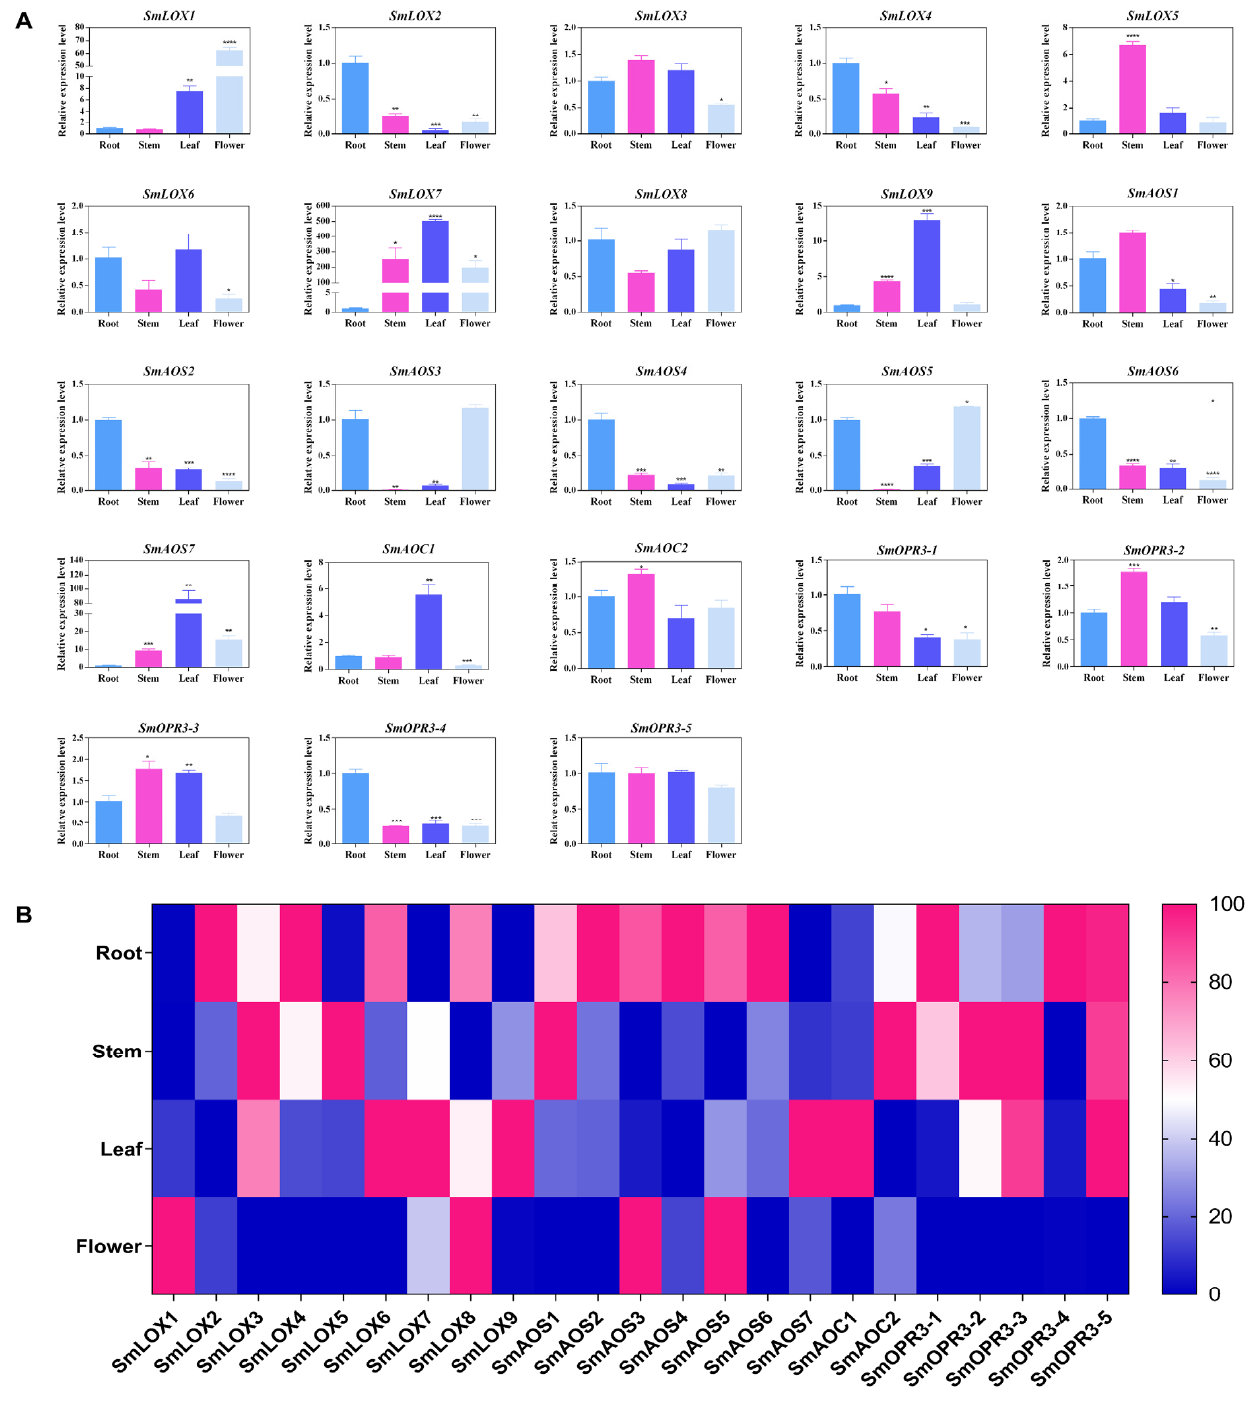
Figure 4. ( A ) Tissue specific expressions of JA biosynthesis related genes. The transcript levels in roots, stems, leaves, and flowers of S. miltiorrhiza were analyzed using the quantitative real-time reverse transcription-PCR method (qRT-PCR). Asterisks ( p < 0.05) indicate significant differences compared with the control group (* p < 0.05, ** p < 0.01, *** p < 0.001, **** p < 0.0001). ( B ) Heat map showing expression profiles of 23 enzyme genes in four different tissues. The graph was generated using GraphPad software based on three repeated counts of log2-transformed RNA-Seq data. Red and blue boxes indicate high and low expressions, respectively.